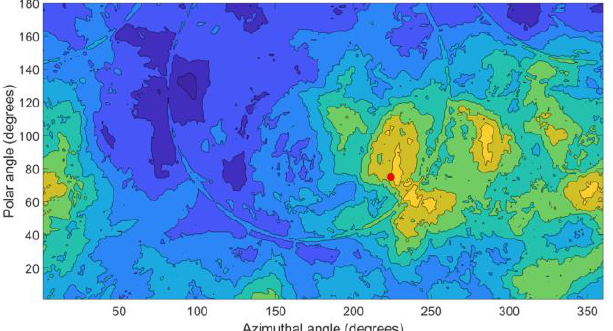
Fig. 10. Raw neutron image of point source measured at (224, 75). The image was generated with a first scatter energy deposition cutoff of 0.2 MeV and a peak prominence ratio cutoff of 4. 154 cones were used to generate the image.